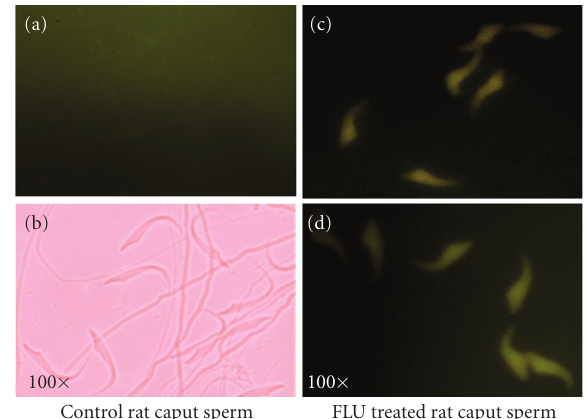
Figure 9: (a) Spermatozoa taken from untreated rats that have not picked up the nuclear chromatin stain viewed under fluorescent microscope at 100 X magnification at 500–610 nm excitation/fluorescence emission wavelength. (b) Spermatozoa of untreated rats that have not picked up the stain viewed under phase contrast objective at 100X magnification. (c)-(d) Spermatozoa taken from the caput epididymides of fluphenazine-treated rats that have picked up the intense yellow CMA3 nuclear chromatin stain in the GC-rich regions occupied normally by protamine. Spermatozoa were fixed in Carnoy’s fixative and stained with CMA3 dye in McIlvaine’s bu ff er. Staining was viewed under fluorescent micro- scope at 100 X magnification at 500–610 nm excitation/fluorescence emission